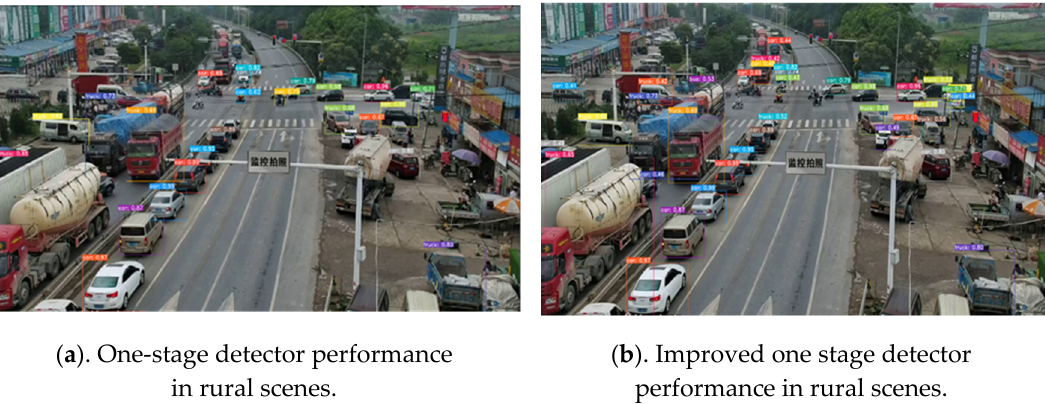
Figure 7. Comparison of improved one-stage detector and one-stage detector in rural environment.